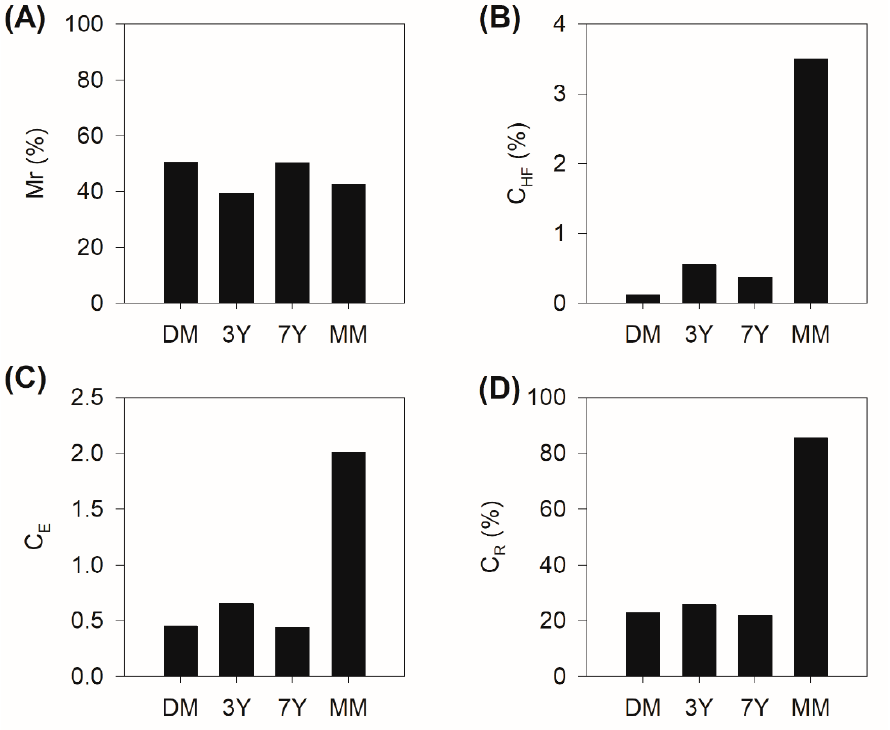
Figure 6. ( A ) Remaining mass (Mr); ( B ) Carbon contents after hydrofluoric acid (HF) treatment (C HF ); ( C ) Carbon enrichment (C E ), and ( D ) Carbon recovery (C R ) results of the demineralization procedure for the degraded mangrove (DM), replanted mangroves (3Y and 7Y), and mature mangrove (MM). Accordingly, the C E values were lower than 1 in the DM, 3Y, and 7Y